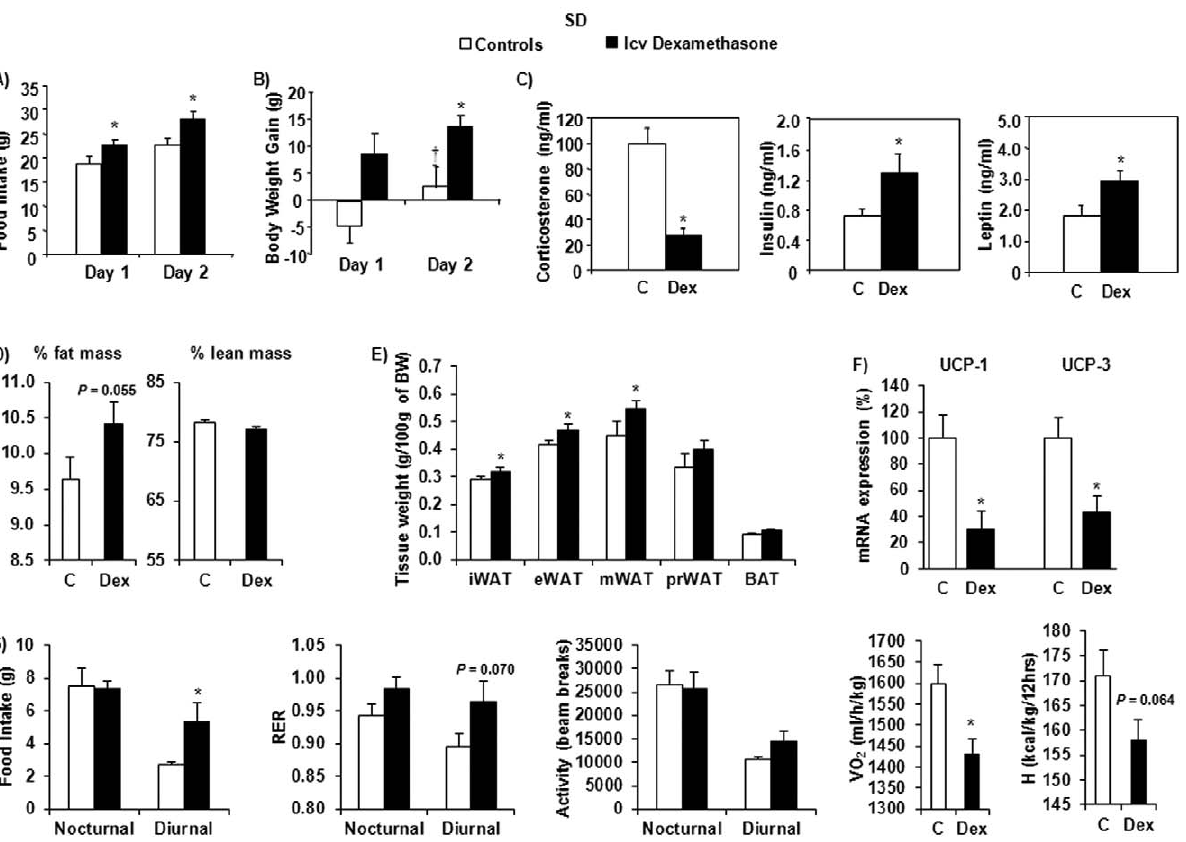
Figure 3. Food intake, body weight gain, plasma corticosterone, insulin and leptin levels, as well as metabolic parameters and locomotor activity of SD rats. Effects of central (icv) dexamethasone infusion for 2 days. A) Results are expressed as food ingested (in grams) each day of icv infusion. B) Results represent body weight gain (in grams) measured after 1 and 2 days of icv infusion. C) Plasma levels of corticosterone, insulin and leptin. D) Body composition (% of fat and lean mass) obtained using EchoMRI700 TM . E) Weight (g/100 g of BW) of inguinal (iWAT), epididymal (eWAT), mesenteric (mWAT) and perirenal (prWAT) white adipose tissue and brown adipose tissue (BAT). F) Results are expressed as percent of relative mRNA expression compared to that obtained in control rats (100%) and normalized with cyclophilin A expression. Mean 6 SEM of n =6–8 rats per group. G) Food intake, respiratory quotient (RER), total activity, VO 2 and heat (H) production measured using indirect calorimetry (LabMaster). Values are mean 6 SE of 5 animals per group. { P , 0.05 compared to day 1, using one-way repeated measures ANOVA (Student- Newman-Keuls test). * P , 0.05 compared to vehicle-infused control rats (Student’s t test).